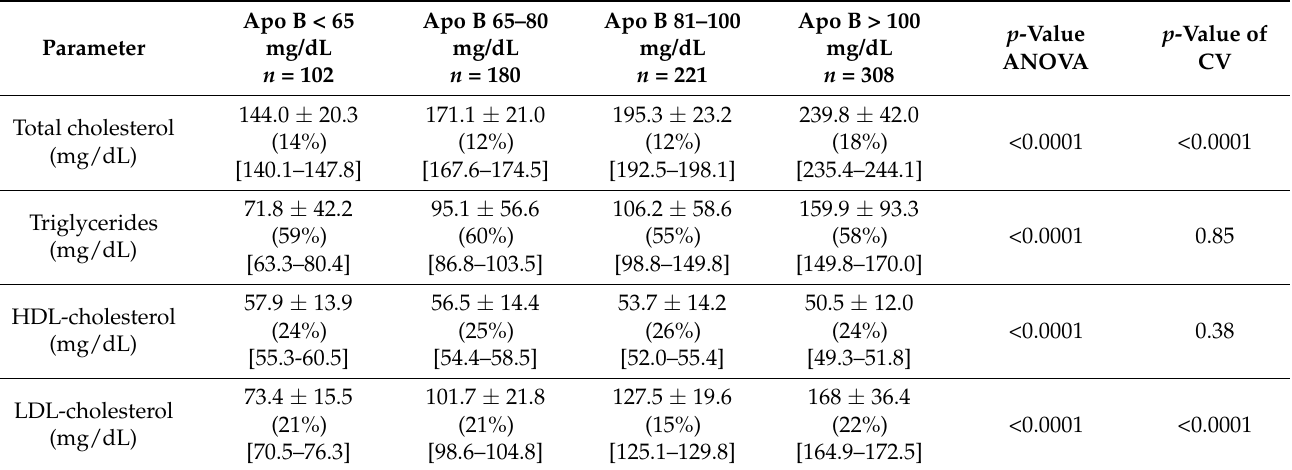
Table 3. Lipid profile in the Apo B risk subgroups .